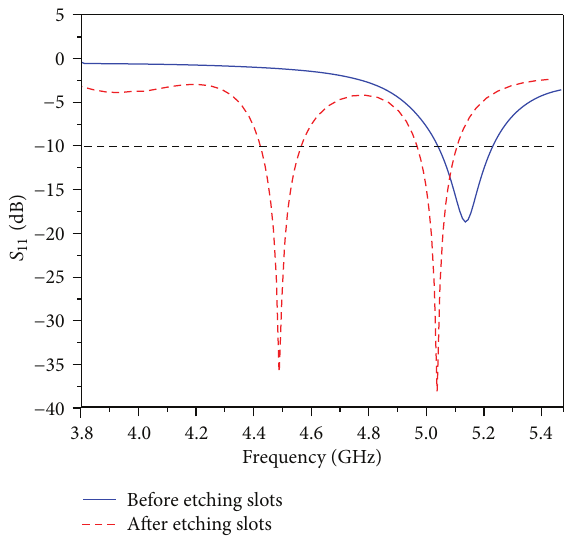
Figure 3: Simulated 𝑆 11 comparison before and after etching slots on the patch surface.